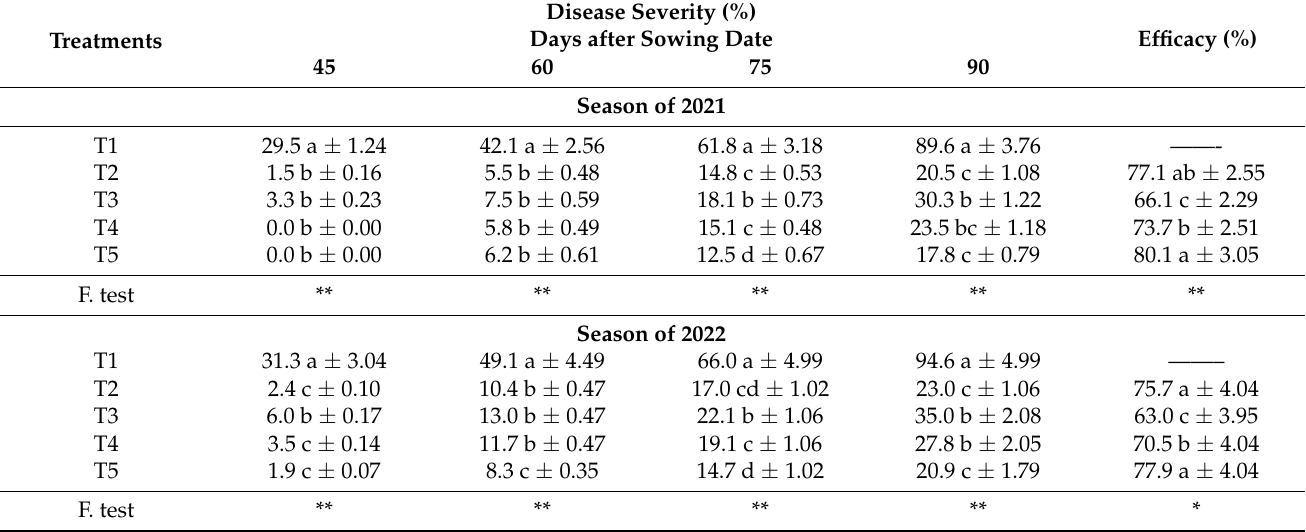
Table 4. Effects of applied nano-Se and nano-SiO 2 treatments on disease severity and efficacy (%) of Alternaria leaf spot disease under field conditions at 45, 60, 75, and 90 days after the sowing of common beans during two seasons, where T1 = negative control, T2 = 100 ppm nano-Se, T3 = 200 ppm nano-SiO 2 , T4 = 1/2 nano-Se + SiO 2 , and T5 = fungicide (Score 250 EC at 1 mL/2